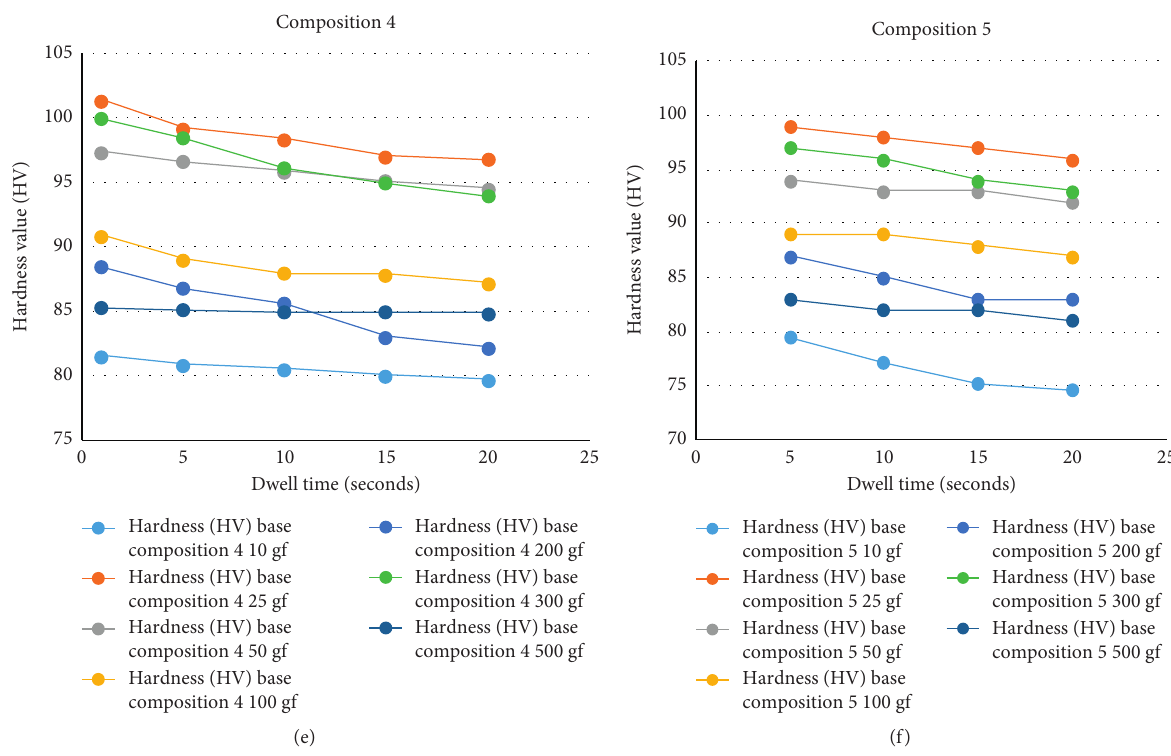
Figure 11: Hardness value versus dwell time graph for different composition